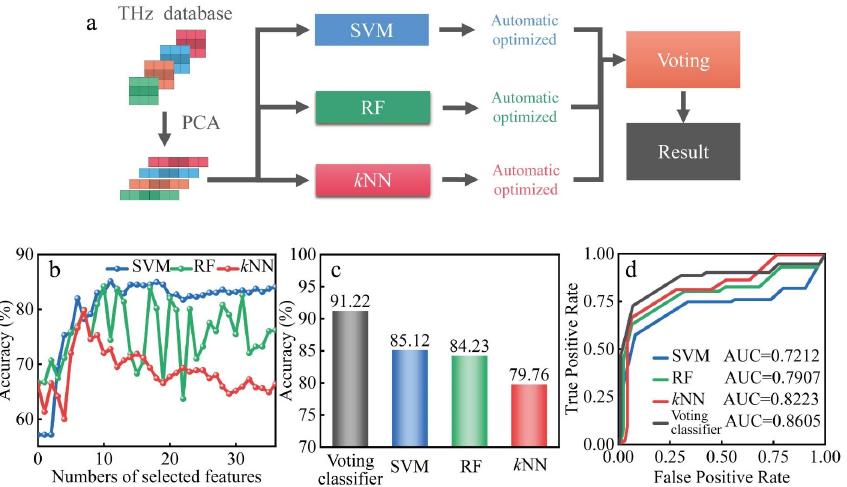
Figure 5. ( a ) Flowchart of the proposed voting classifier for the biological THz images. ( b ) The classification accuracy of k NN, SVM, and RF with the different numbers of features. ( c ) The highest classification accuracy of different classifiers. ( d ) The ROC curve and AUC scores of different classifiers when they reach the highest accuracy. Table 2. The identification metrics of AI-assisted THz imaging.